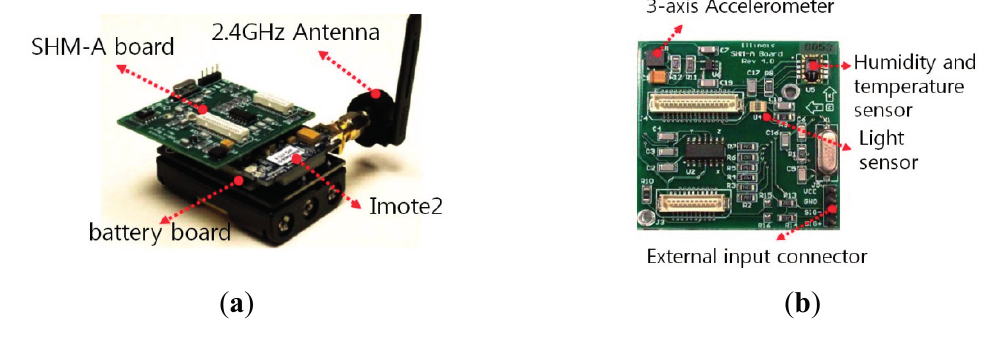
Figure 3. Hardware components of wireless sensor node. ( a ) Imote2; ( b ) ISM400